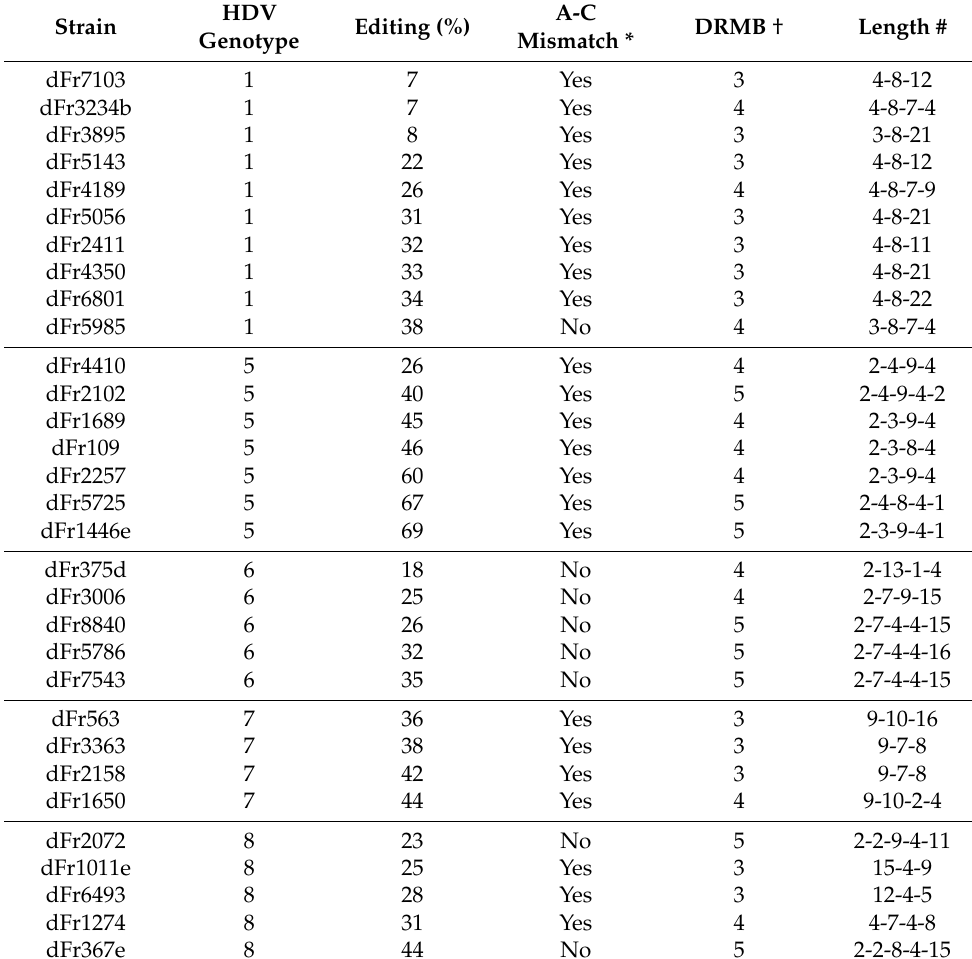
Table 2. Structural features of the minimal editing region inside the 25 nucleotides 3 (cid:48) -downstream of the editing site according to the HDV